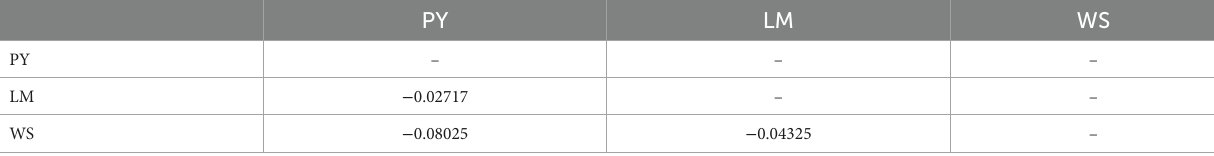
TABLE 8 Pairwise genetic differentiation Fst among Pseudokabatana alburnus isolates based on Rpb1